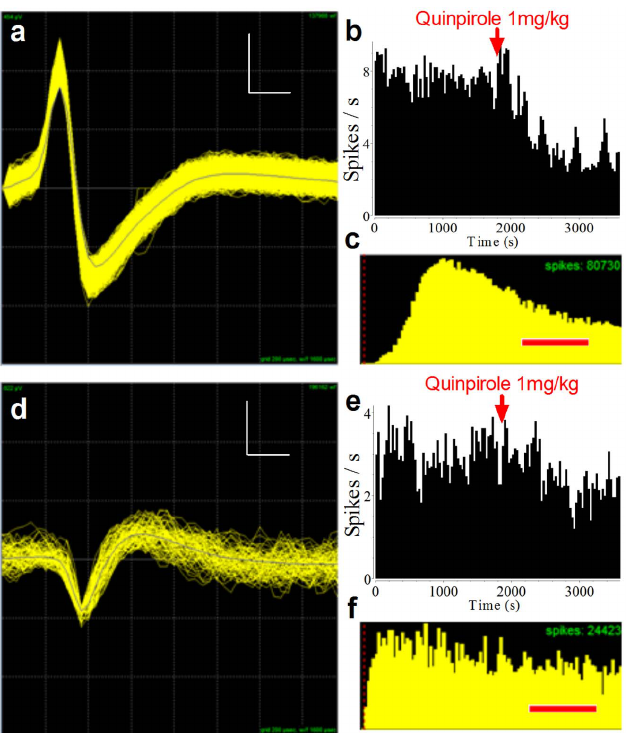
Figure 2. Effects of quinpirole on dopaminergic and GABAergic neurons. To confirm the classification of cell types, we performed additional pharmacological experiments. Quinpirole (1 mg/kg), a D2 receptor agonist, was injected intraperitoneally during a recording session (red arrows). Example responses of DA ( a – c ) and GABA ( d – f ) neurons to quinpirole treatment are shown. Immediately following injection, the rate of dopaminergic firing decreased ( b ), whereas GABAergic neurons were unaffected ( e ). ( c, f ) Inter-spike interval histograms for the neurons in a and d . In a and d , vertical scale bars represent 76 m V and 137 m V, respectively. Horizontal scale bars represent 200 m s. Scale bars in c and f represent 25 ms.